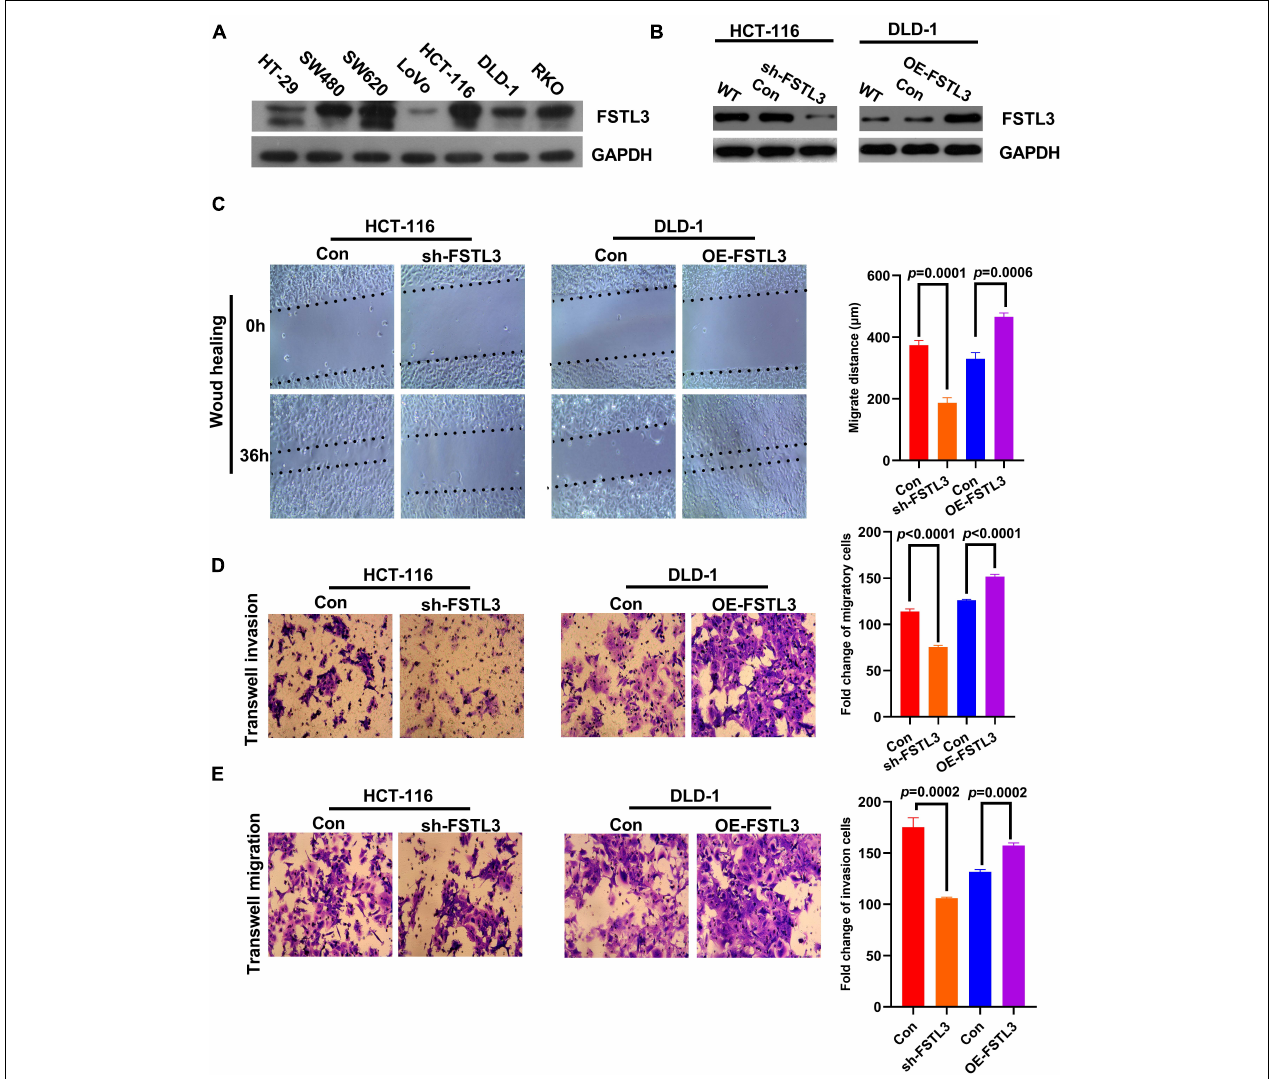
FIGURE 2 | FSTL3 promotes migration and invasion of CRC cells in vitro . (A) Protein expression levels of FSTL3 in CRC cell lines. (B) WB analysis of FSTL3 knockdown and overexpression. (C) The wound-healing assays were applied to detect migration capacity (timepoints 0 and 36 h) affected by FSTL3 in HCT-116 and DLD-1 cells. (D,E) Transwell assays were utilized to quantify migration and invasion capacity affected by FSTL3 in HCT-116 and DLD-1 cells. Data are presented as the mean ± SD from three independent